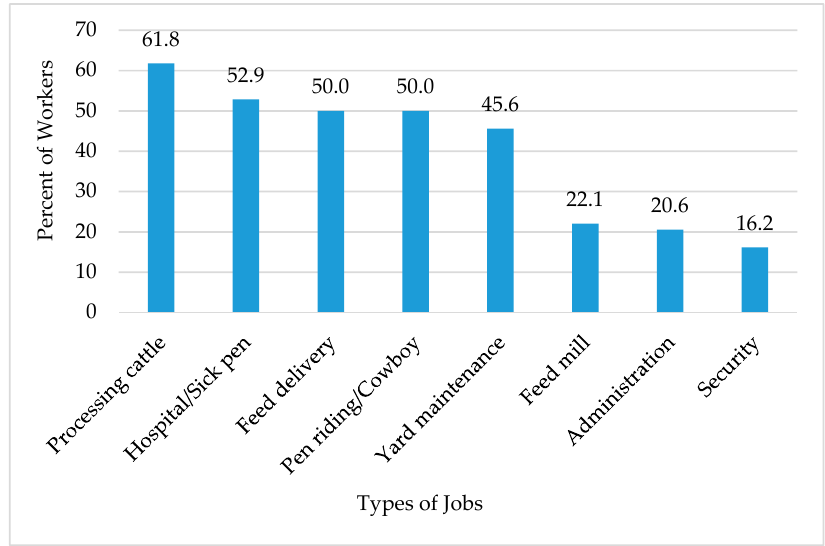
Figure 1. Percent of participants by job type.